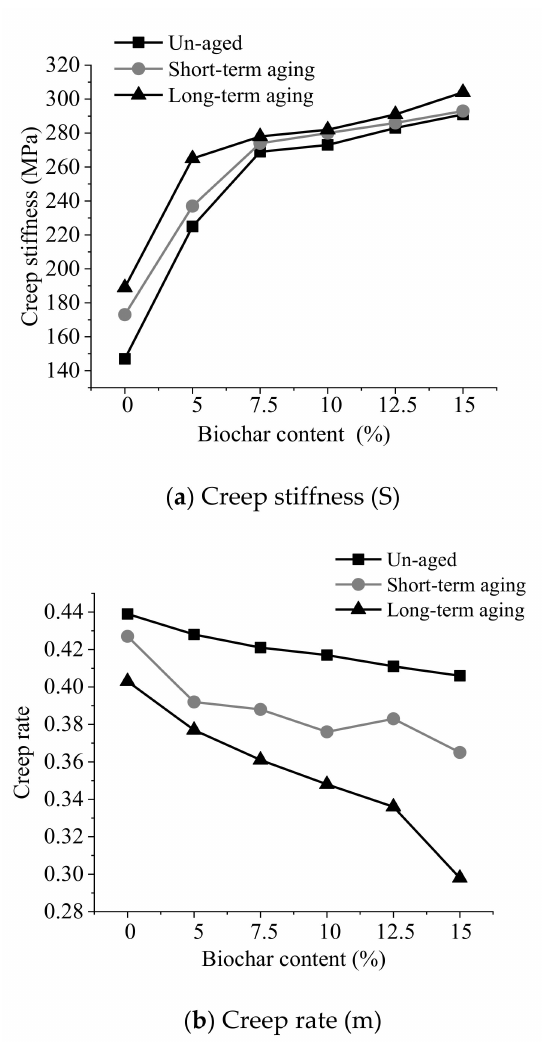
Figure 9. Bending beam rheometer (BBR) results under di ff erent aging